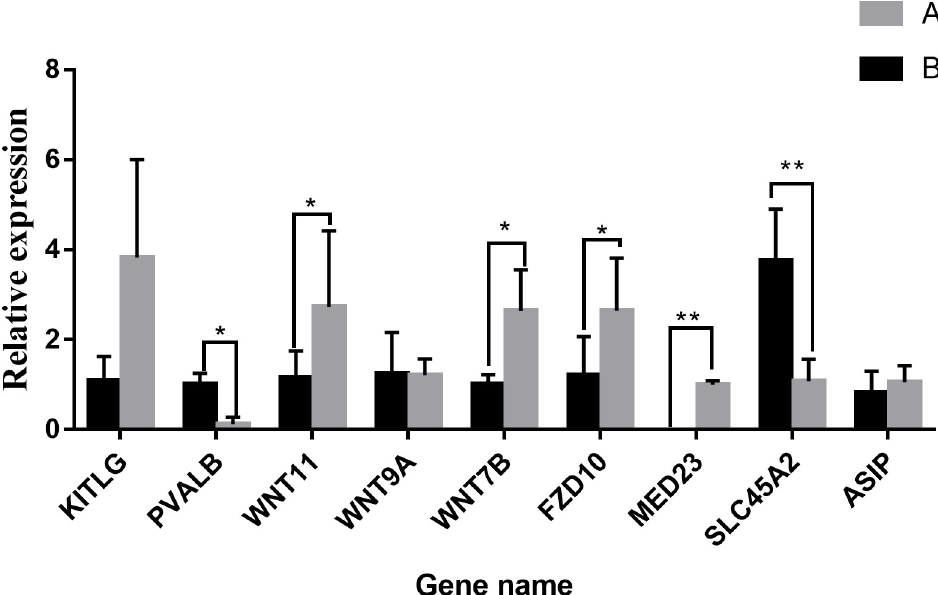
Fig 2. Verification of DEGs via qRT-PCR. The 2 - ΔΔ CT method was used for data analysis, and the housekeeping gene was GAPDH. Data shown on the vertical-axis represents the relative expression. Significant differences between two groups were determined by applying the unpaired Student’s t-test. � 0.01 < p < 0.05, �� p < 0.01. All dataare presented as means ± standard error (SE).